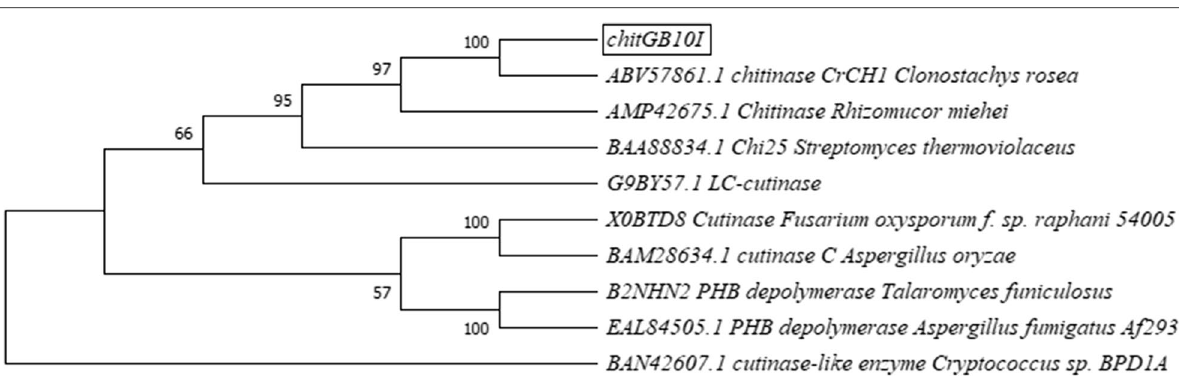
Fig. 6 Neighbour-joining tree of chitGB10I ( Geomyces sp. B10I) and other enzymes with the biodegradation activity. The bootstrap consensus tree inferred from 1000 replicates and the percentage of replicate trees in which the associated taxa clustered together in the bootstrap test is shown next to the